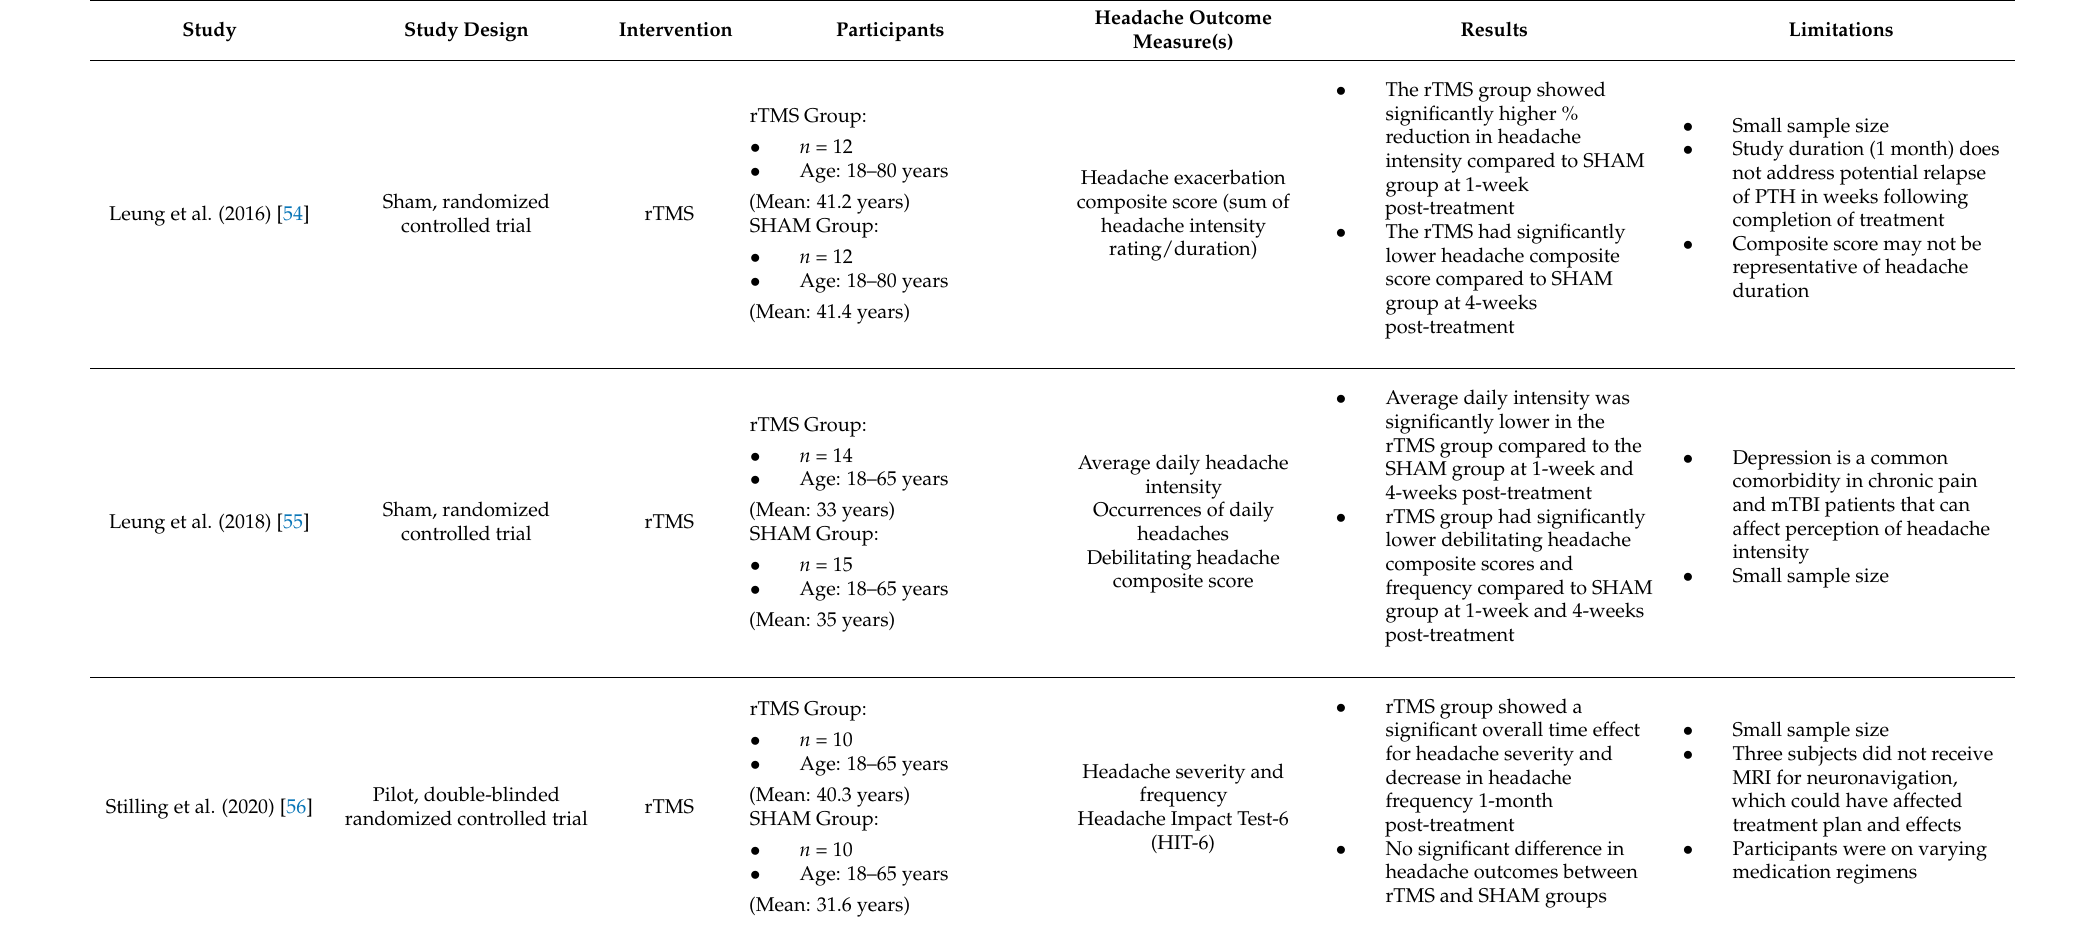
Table 2. Summary of study findings of neuromodulation interventions for management of post-traumatic